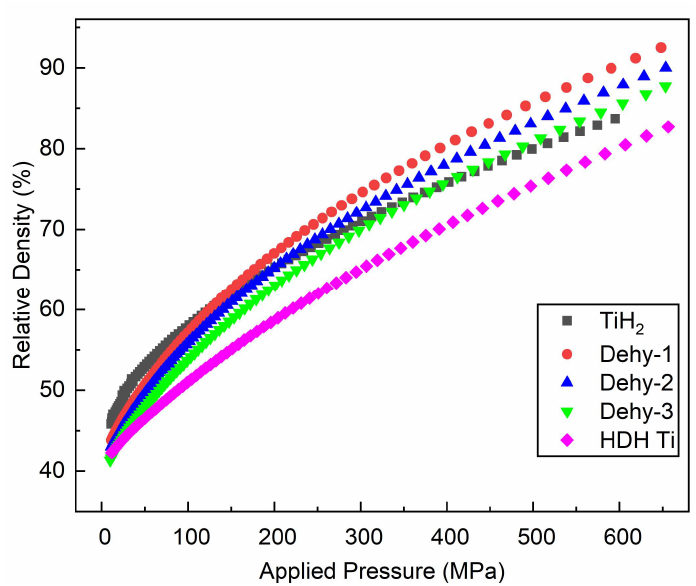
Figure 5. Relative density vs pressure of TiH 2 , Dehy-1, Dehy-2, Dehy-3, and HDH Ti powders. Apart from density, green strength determines the ability of green compact to retain